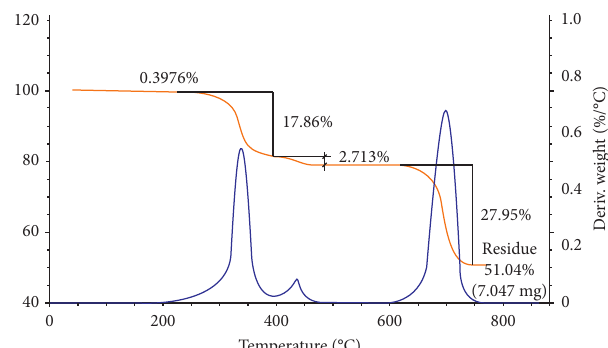
Figure 1: TGA decomposition curve of BMC.